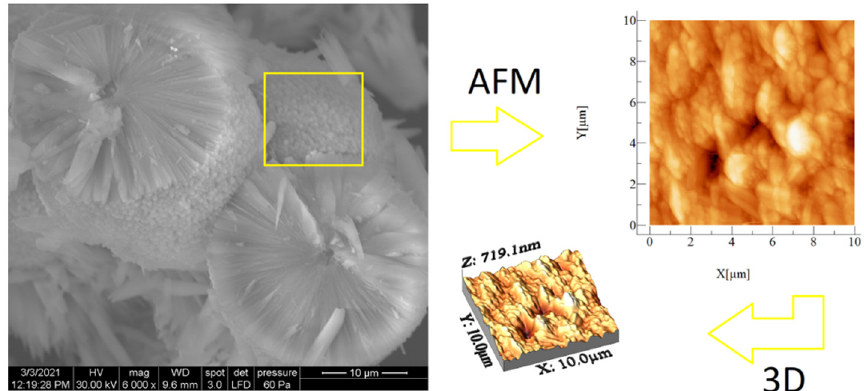
Figure 6 . SEM and AFM images at different scales for the S LowTP sample. The yellow square on the SEM image it’s indicative of the surface area analyzed by AFM (image at right).